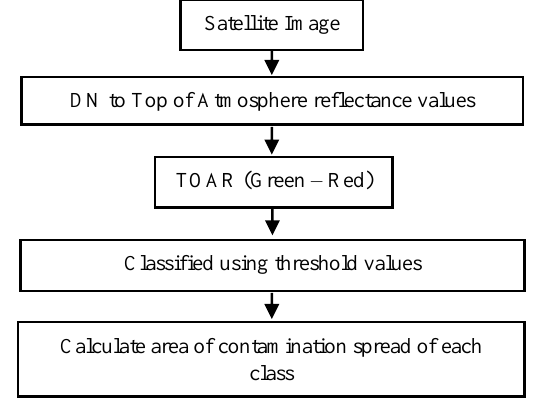
Figure 2: Flowchart showing the procedure followed for this